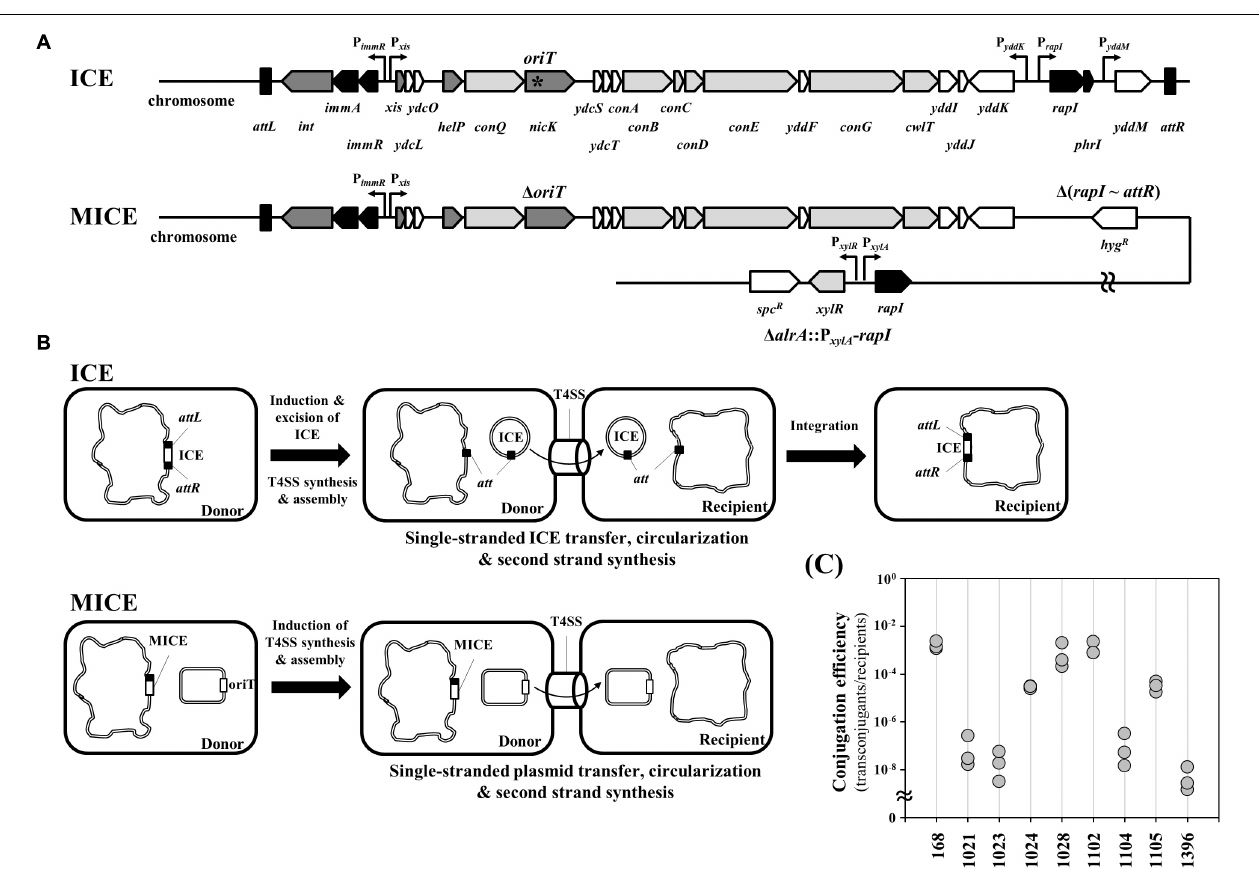
FIGURE 2 | Modification of an integrative and conjugative element of B. subtilis to deliver plasmid. (A) Comparison of genetic organization between ICE and MICE. The asterisk means the oriT nicking site. (B) Scheme of DNA transfer mechanism through ICE or MICE. In ICE system, the chromosomal ICE of donor strain is excised using attL and attR . After transferring, the ICE is integrated into the genome of the recipient. MICE system can transfer oriT -carrying plasmid from donor to recipient. (C) Conjugation efficiency for undomesticated B. subtilis strains using MICE system. The conjugation efficiency was calculated by dividing the number of transconjugants by the number of recipient cells. The numbers are KCTC strain numbers and the 168 indicates B. subtilis strain 168. Three independent experiments were performed and the results are presented as closed